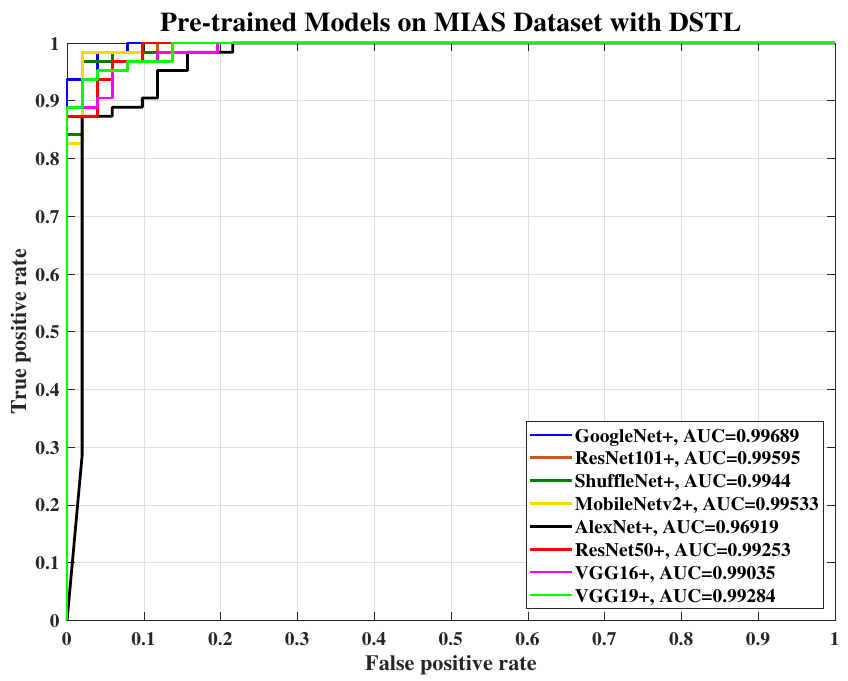
Figure 8. The ROC curve of various pre-trained models with DSTL for breast cancer classification using the MIAS dataset, where the AUC of each pre-trained model has been improved.